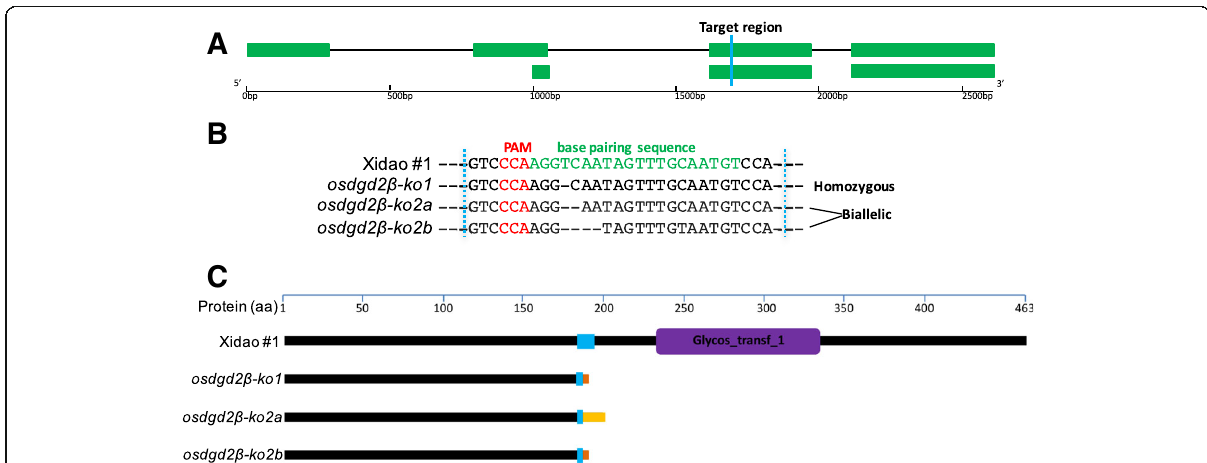
Fig. 3 Targeted mutagenesis of OsDGD2 β using CRISPR/Cas9 system. a Two transcripts of OsDGD2 β with the target region shown in blue. b DNA sequences of the target region with PAM and genome specific sgRNA sequence shown in red and green, respectively. osdgd2 β -1 is a homozygous mutant with 1-bp deletion while osdgd2 β -2 is a biallelic mutant with 2-bp ( osdgd2 β -2a) and 5-bp ( osdgd2 β -2b) deletion. c schematic representation of truncation in protein translation in the mutants. Purple colour depicts the only domain (Glycos_transf_1), changes in amino acid sequences in the mutants ’ protein are shown in brown and yellow colour after the target